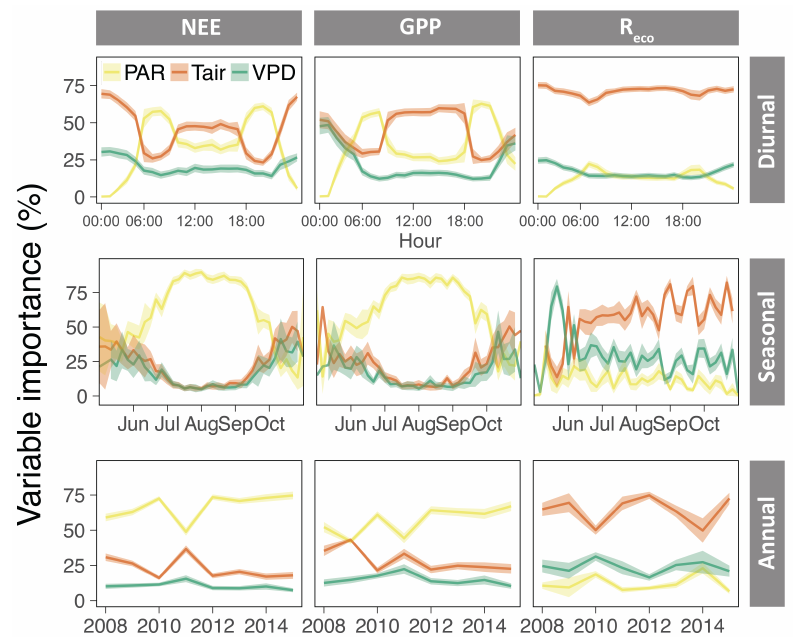
Figure 8. Diurnal, seasonal and annual importance of environmental variables PAR (yellow), T air (orange), and VPD (green), explaining variability in NEE, GPP and R eco . Thick lines and shading represent the mean ± standard deviation of the importance across 1000 decision